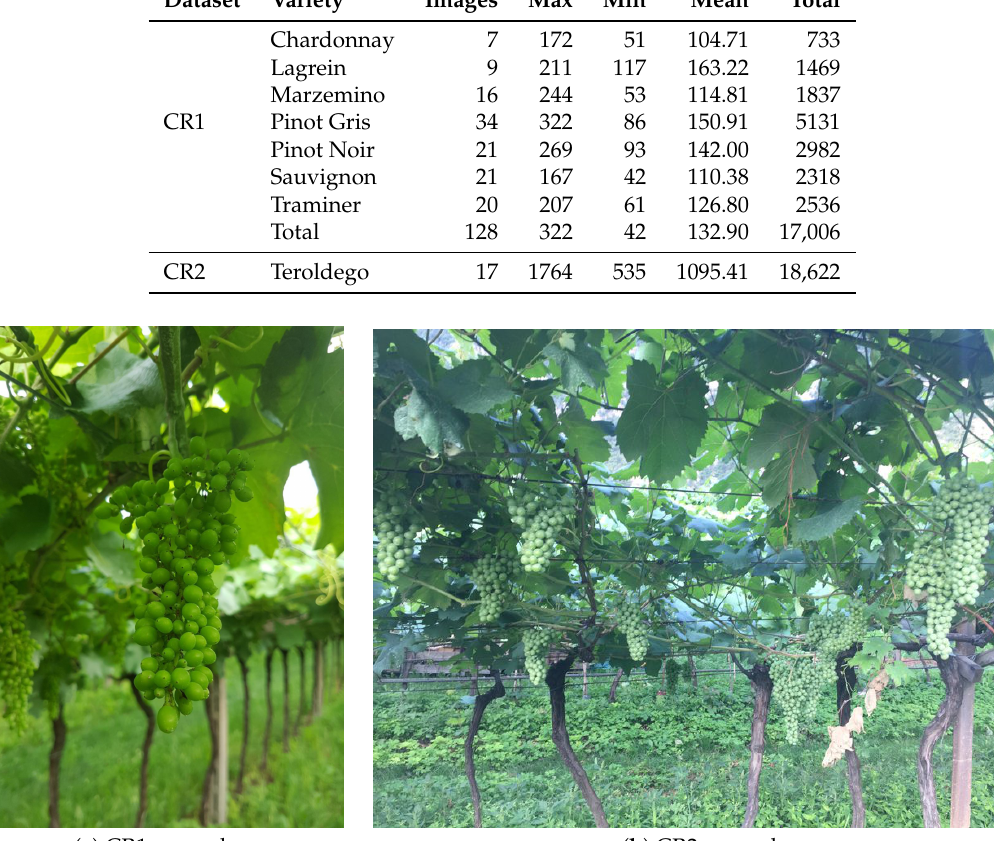
Figure 3. Example of close-up and medium distance images present in CR1 ( a ) and CR2 ( b ) datasets